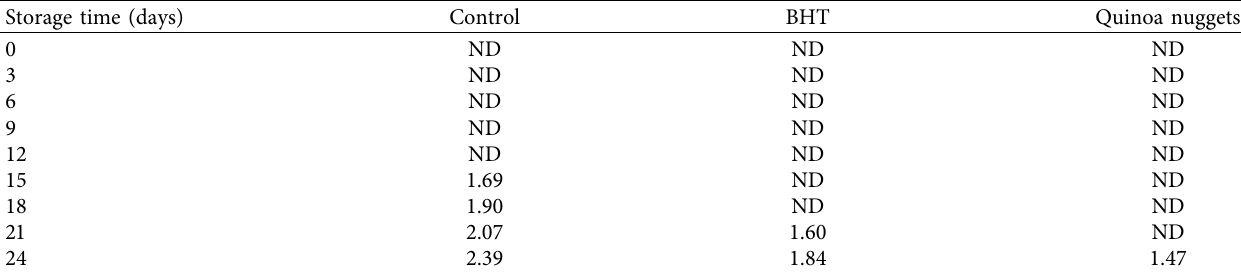
Table 2: Total yeast and mold count (log cfu/g) of chicken nugget samples during storage at 4 ° C for 24 days. Storage time